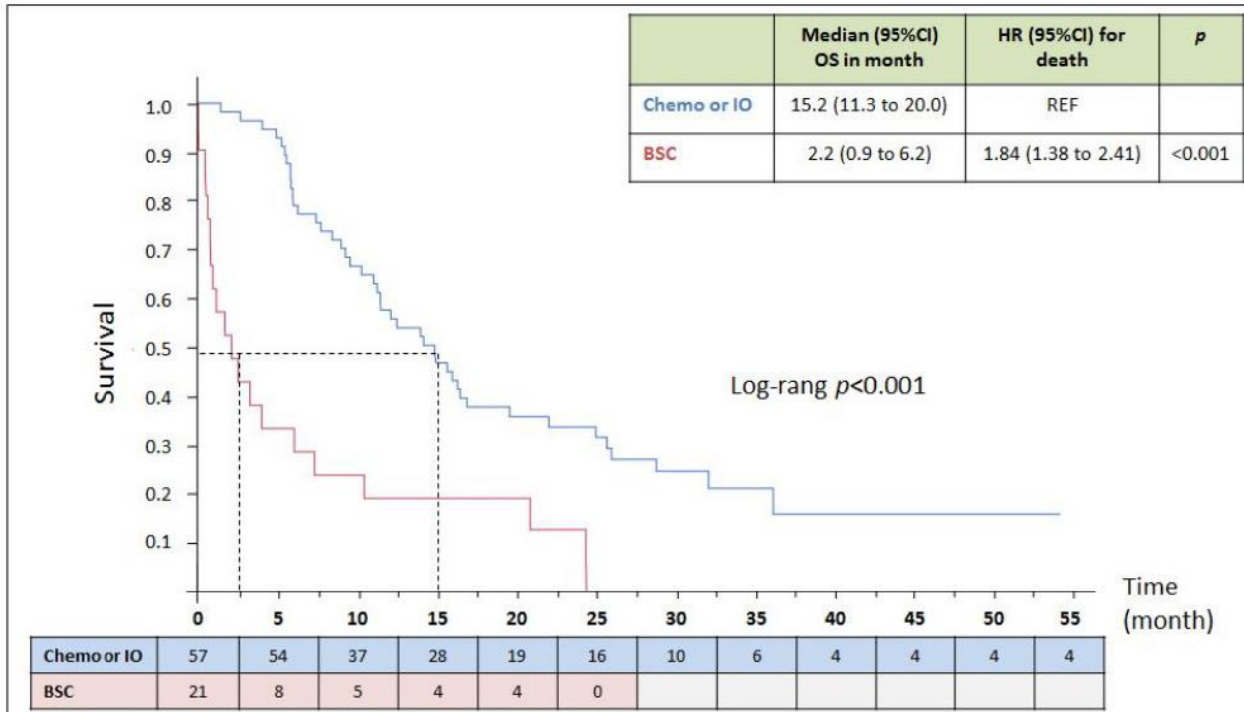
Figure 2. Overall survival according to therapeutic strategy ( n = 78). The Kaplan–Meier curves represent the survival over time in patients diagnosed during the inclusion period according to the therapeutic strategy: Chemotherapy or Immunotherapy, or BSC. The day of the biopsy was considered as baseline. The number of participants alive over time is detailed in the table under the curves. Chemo: chemotherapy; IO: immunotherapy; BSC: best supportive care. In the 38 participants with GA, WS was not associated with OS. Kaplan–Meier curves according to WS are displayed in Figure 3. OS was 14.3 (IQR: 6.1-NR) months for patients with WS < 1 m/s, and 17.3 (IQR: 9.2–26.5) months for patients with WS ≥ 1 m/s ( p =